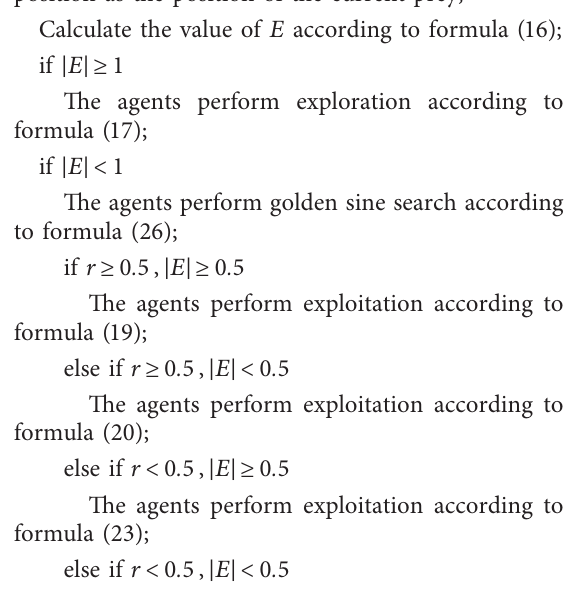
curve, but move according to a gold sine curve [37]. During each iteration, the ability that agents search within a certain local improved is expanded, when the agents move according to this golden sine curve. This golden sine curve path shape in two-dimensional space is shown by the red curves in Figure 3 [37].